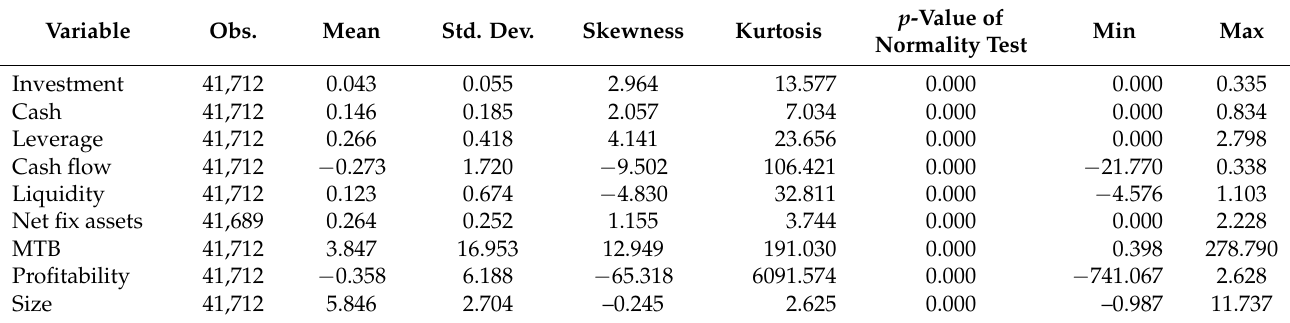
Table 3. Descriptive Statistics: All